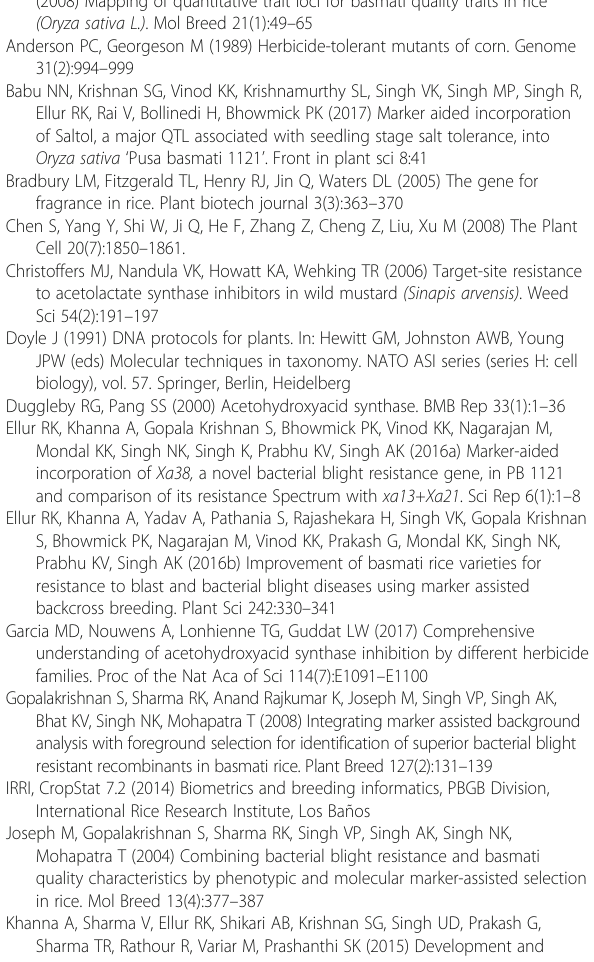
Additional file 1: Figure S1. Agarose gel image (a-e) of all 112 SSR markers polymorphic between RP PB 1121 and DP Robin. M: 50 base pair DNA ladder; P1: PB 1121; P2: Robin. Additional file 2: Figure S2. Chromosome wise Graphical representation of all 112 SSR markers polymorphic between RP PB 1121 and DP Robin. Additional file 3: Figure S3. Gel image showing the amplification profile of AHAS linked SSR marker RM6844 in the F 1 plants. M: 50 base pair DNA ladder; DP: Robin; RP: PB 1121; 1 – 15: F 1 plants. Additional file 4: Figure S4. A representative gel amplification image of the SSR marker, RM6844 used in foreground selection in the BC 4 F 2 population. M: 50 base pair DNA ladder; RP: PB 1121; DP: Robin; 1 – 68: